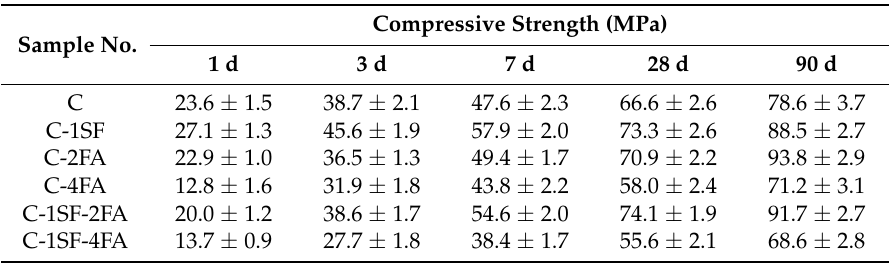
Table 3. Compressive strength of cement pastes.